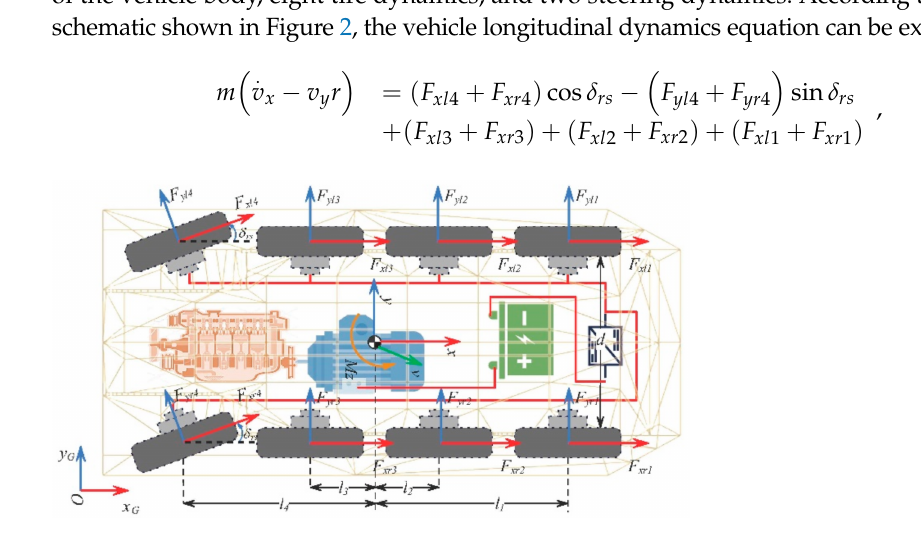
Figure 2. The overall configuration and force analysis